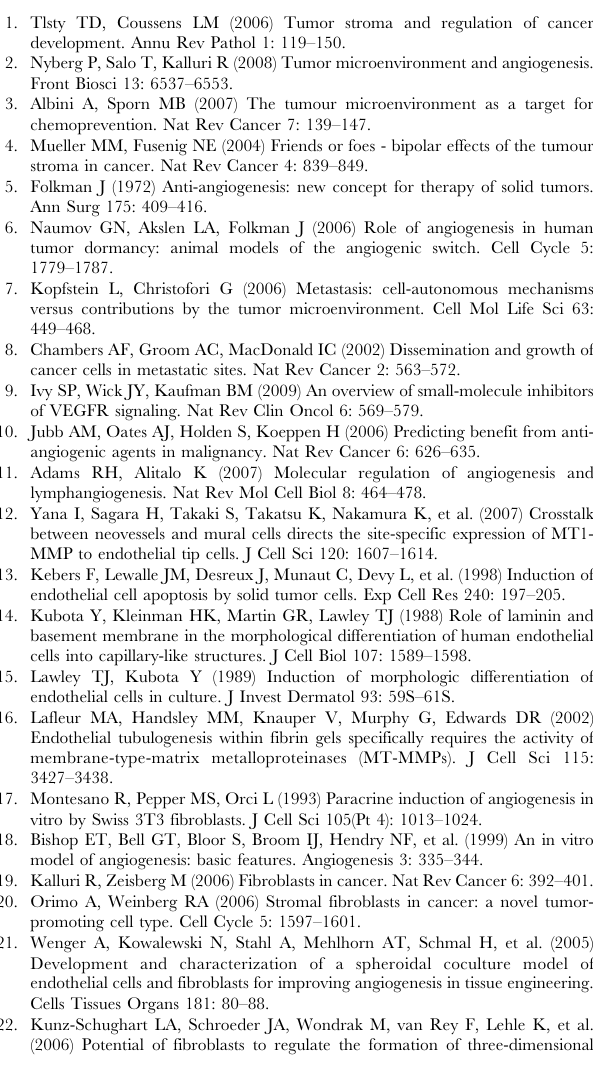
showing pre-dyed green endothelial cells as well as red staining for the markers indicated (CD31, CD34 and LYVE-1). Figure S3 Minitumour spheroids cultured for 7 days show lumen formation. Minitumour spheroids cultured for 7 days were fixed with glutaraldehyde, embedded in araldite epoxy resin, sectioned and imaged using a Tecnai G 2 transmission electron microscope. Four different representative images are presented showing lumen formation (asterisk). Black arrow indicates a dying cell inside a lumen, probably in the process of its formation. f – fibroblast. Scale bar corresponds to 2 m m in A, B, C and 500 nm in D. Figure S4 MT1-MMP gene silencing in MDA-MB-231 cells has no effect on endothelial cell sprout